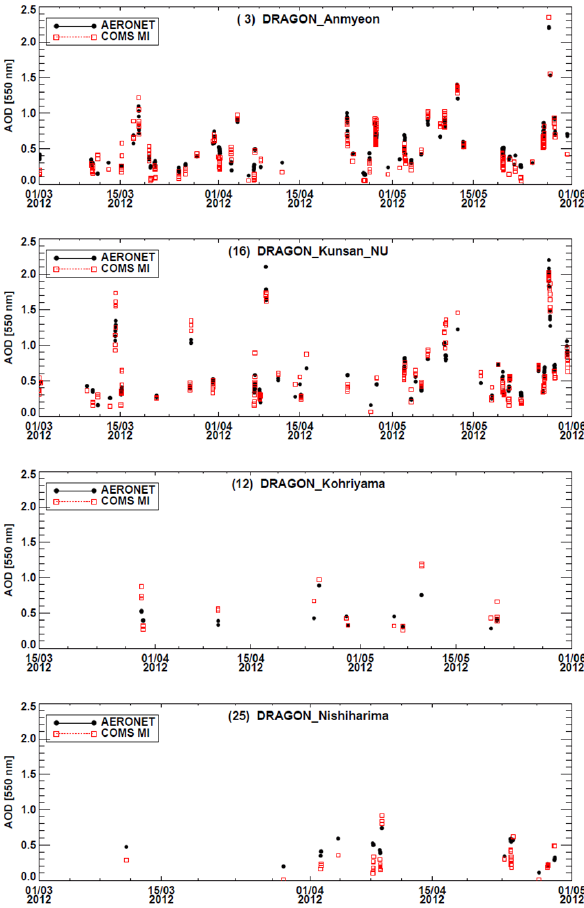
Figure 11. Temporal variations of AODs during the DRAGON-NE Asia campaign. The red boxes and black circles represent the val- ues retrieved from MI and AERONET measurements, respectively, and each panel shows the time series for different AERONET sites: (a) Anmyeon, (b) Kunsan_NU, (c) Kohriyama, (d) Nishi-Harima.